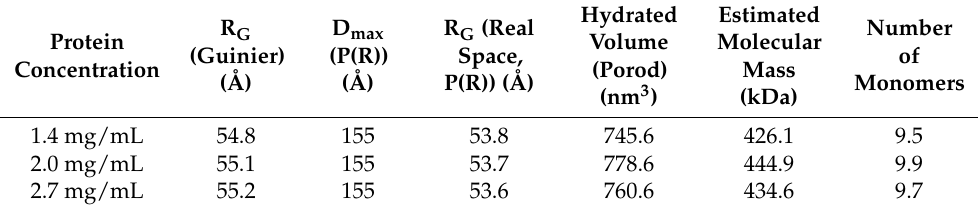
Table 1. SAXS parameters for the gp11